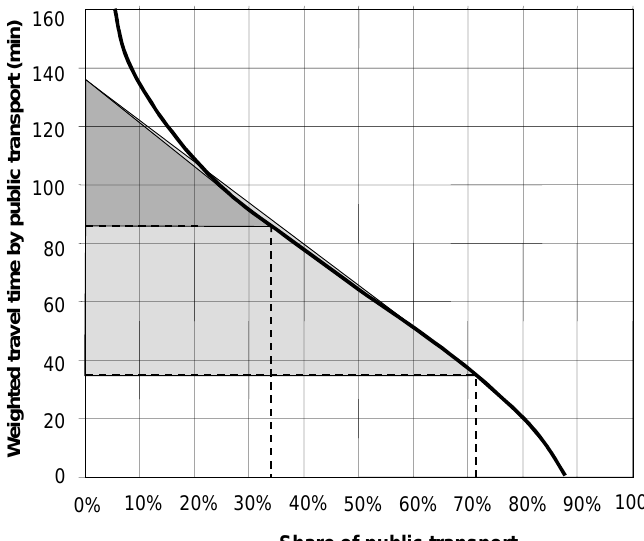
Figure 2. Two examples of the simplified representation of consumer surplus using a logit-